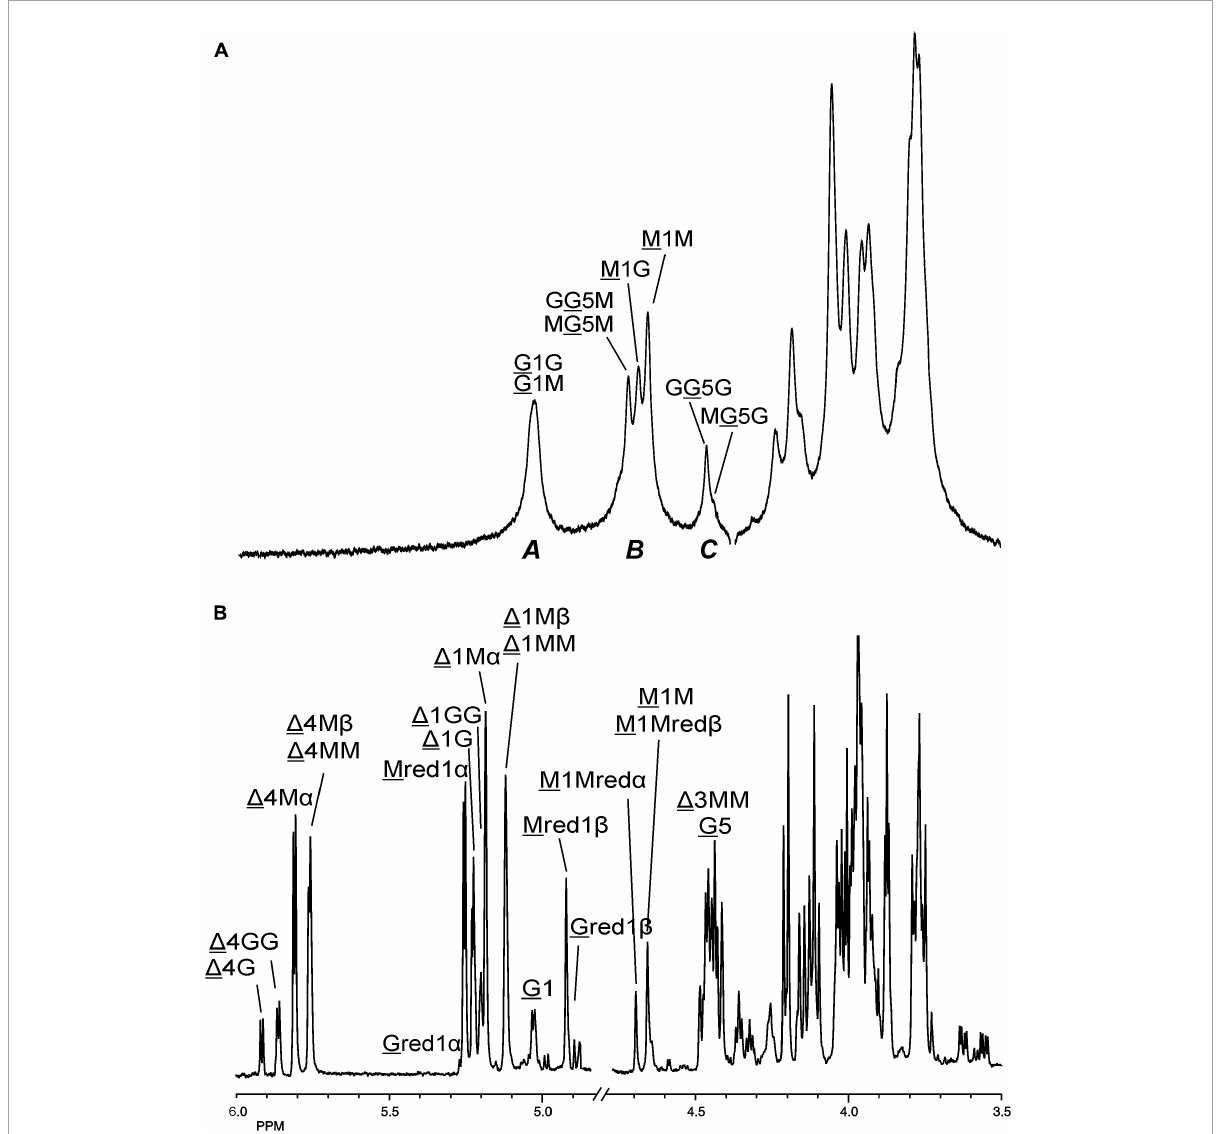
for the coding system in panel (B) , see Figures 4 , 5 . M1Mred α and M1Mred β /M1M mean M H-1 of internal